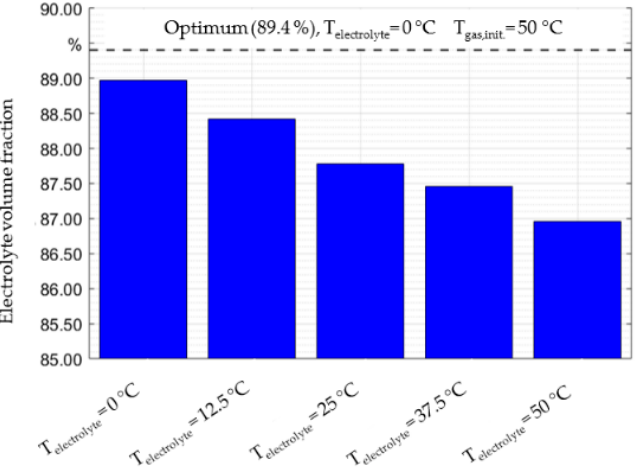
Figure 5. Electrolyte volume fraction as a function of gas and electrolyte temperature. Dosing pressure (1000 mbar), initial evacuation pressure (100 mbar) and an initial gas temperature (25 °C) are constant.